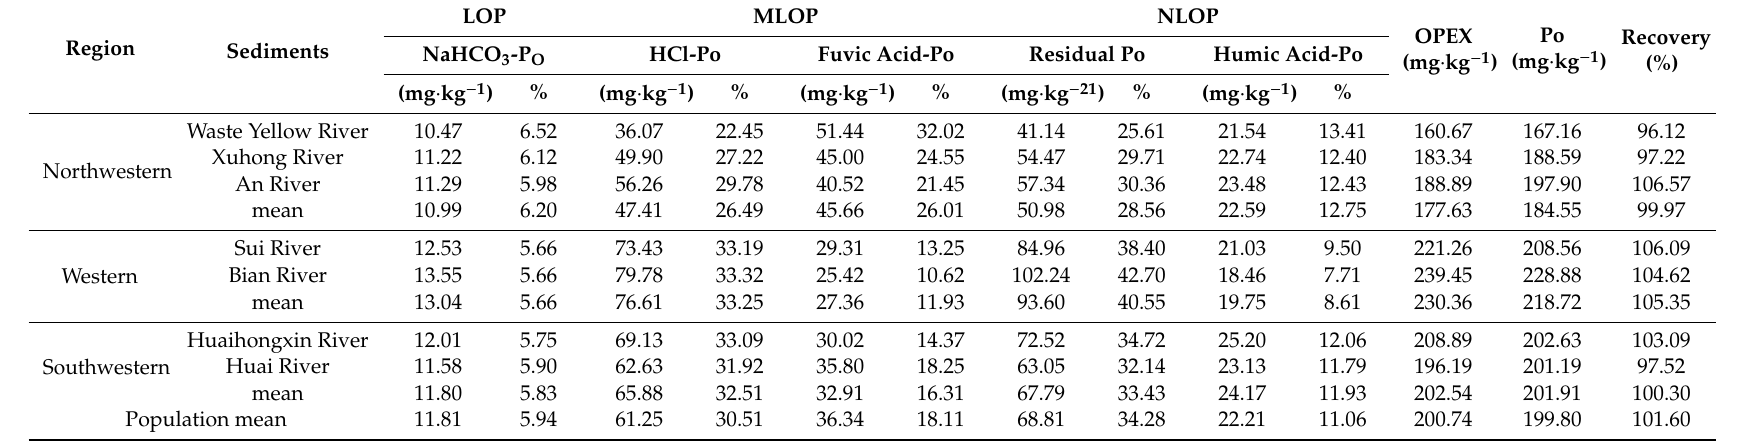
Table 2. Distributions and the recovery of di ff erent Po fractions in the sediments. Labile organic phosphorus (LOP) moderately labile organic phosphorus (MLOP) and non labile organic phosphorus (NLOP), total extracted phosphorus